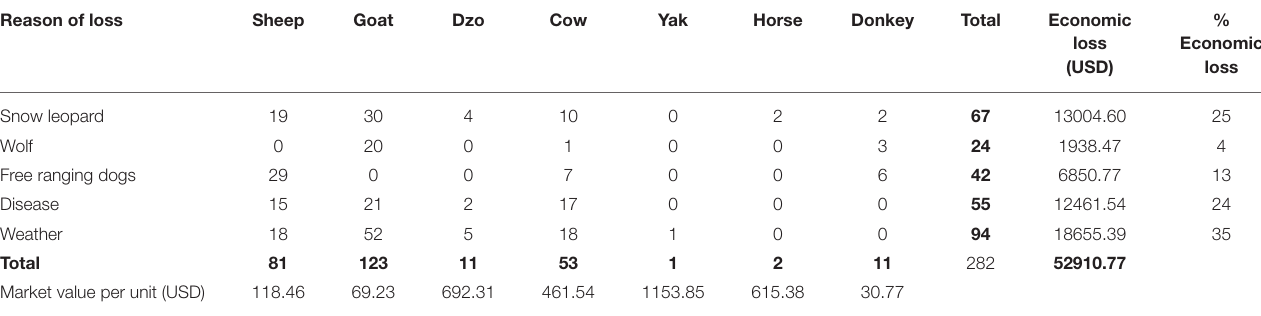
TABLE 2 | Economic losses because of livestock mortality and depredation due to wild carnivores, free ranging dogs, disease and weather from January 2016 to March 2017. Reason of loss Sheep Goat Dzo Cow Yak Horse Donkey Total Economic